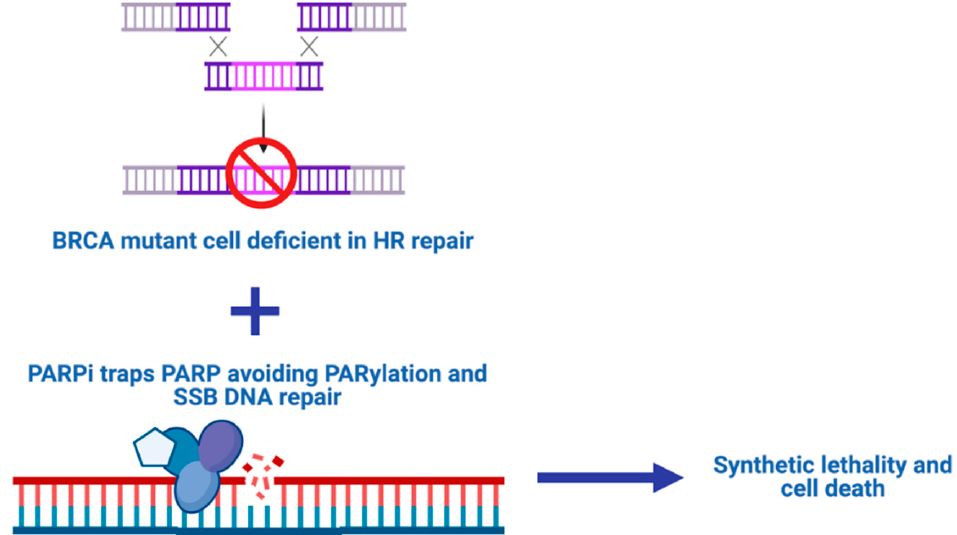
Figure 1. PARP-associated synthetic lethality. PARPi activity is based on the concept of synthetic lethality. BRCA mutant cells are deficient in the HR pathway when a PARPi is associated. In addition, SSB repair is inhibited and apoptosis is induced.